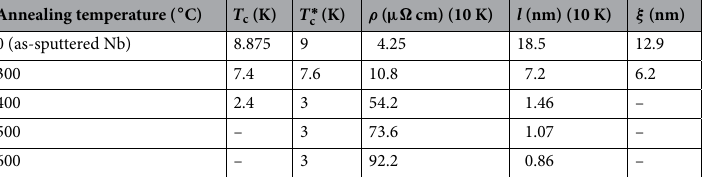
Annealing temperature ( ◦